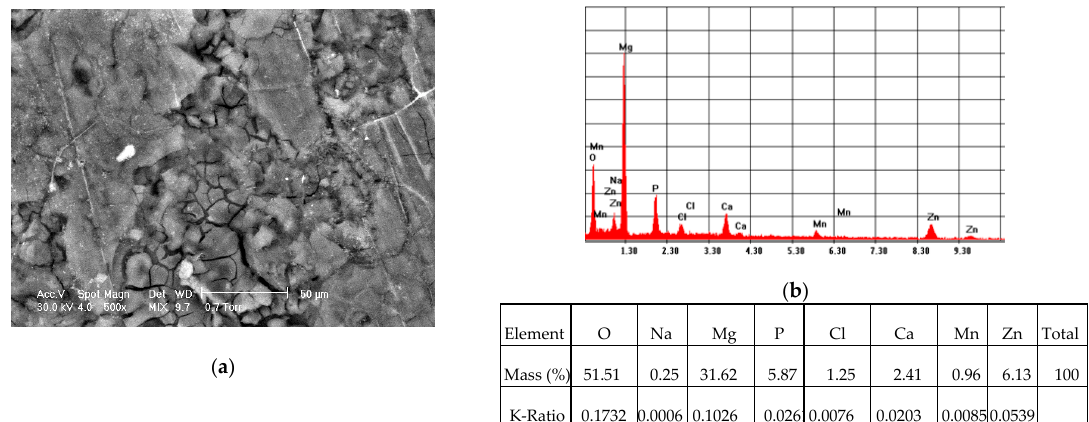
Figure 16. Representative SEM images (magnification 500×) of the HAP coated ZMX410 sample ( a ), and corresponding EDS spectrum ( b ) of corroded areas, after electrochemical corrosion in SBF.